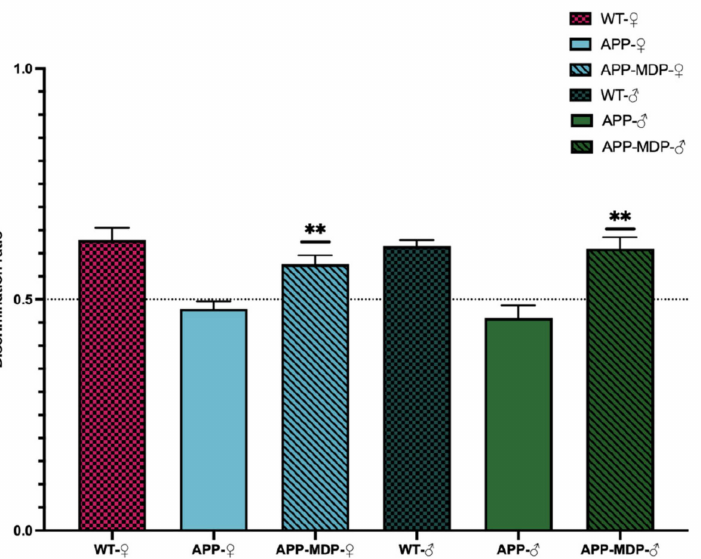
Figure 3. MDP has a powerful impact on the short-term memory of APP mice. Novel object recognition tasks with 2-time-point comparison of male or female WT and APP Swe /PS1 from 3 to 6 months. Discrimination differs from 0.5. Data are mean ± SEM ( n = 8 animals/group). ** p < 0.01 compared to sex-matched APP Swe /PS1